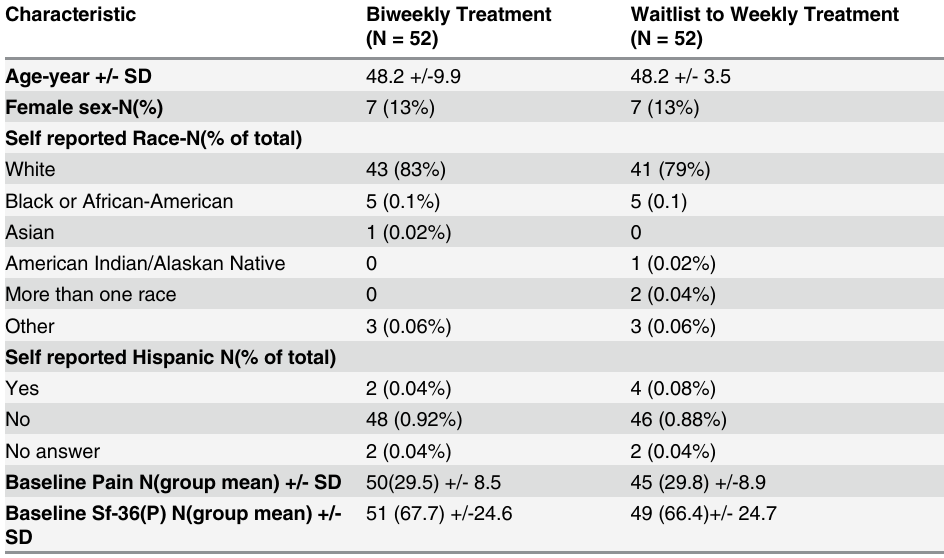
Table 1. Baseline Characteristics of the Study Population. Baseline Characteristics of the Study Popula- tion. Standard Deviations (SD) are offered for age, baseline pain, and baseline Sf-36(P). Characteristic